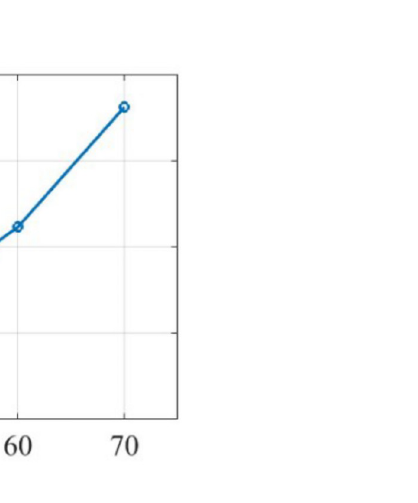
Fig 10. Radial stiffness corresponding to different rubber ring